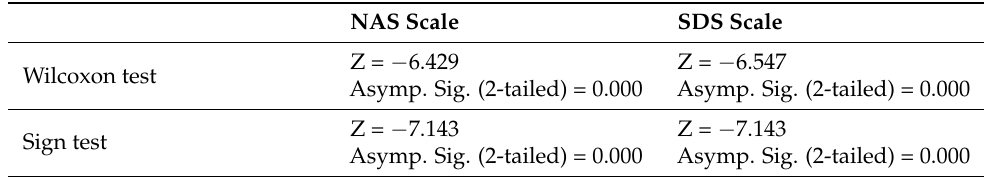
Table 1. Wilcoxon and the Signs test for adequacy of the